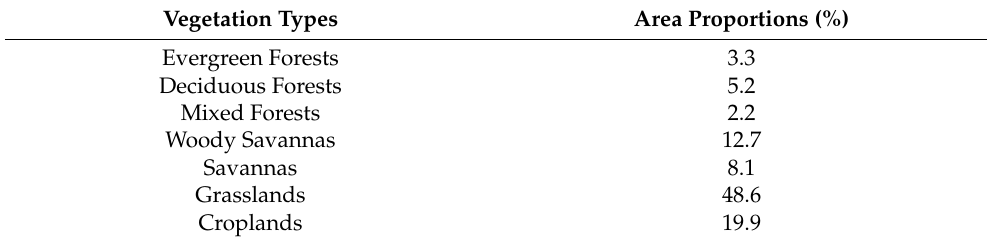
Table 1. Vegetation types and their area proportions of the selected study